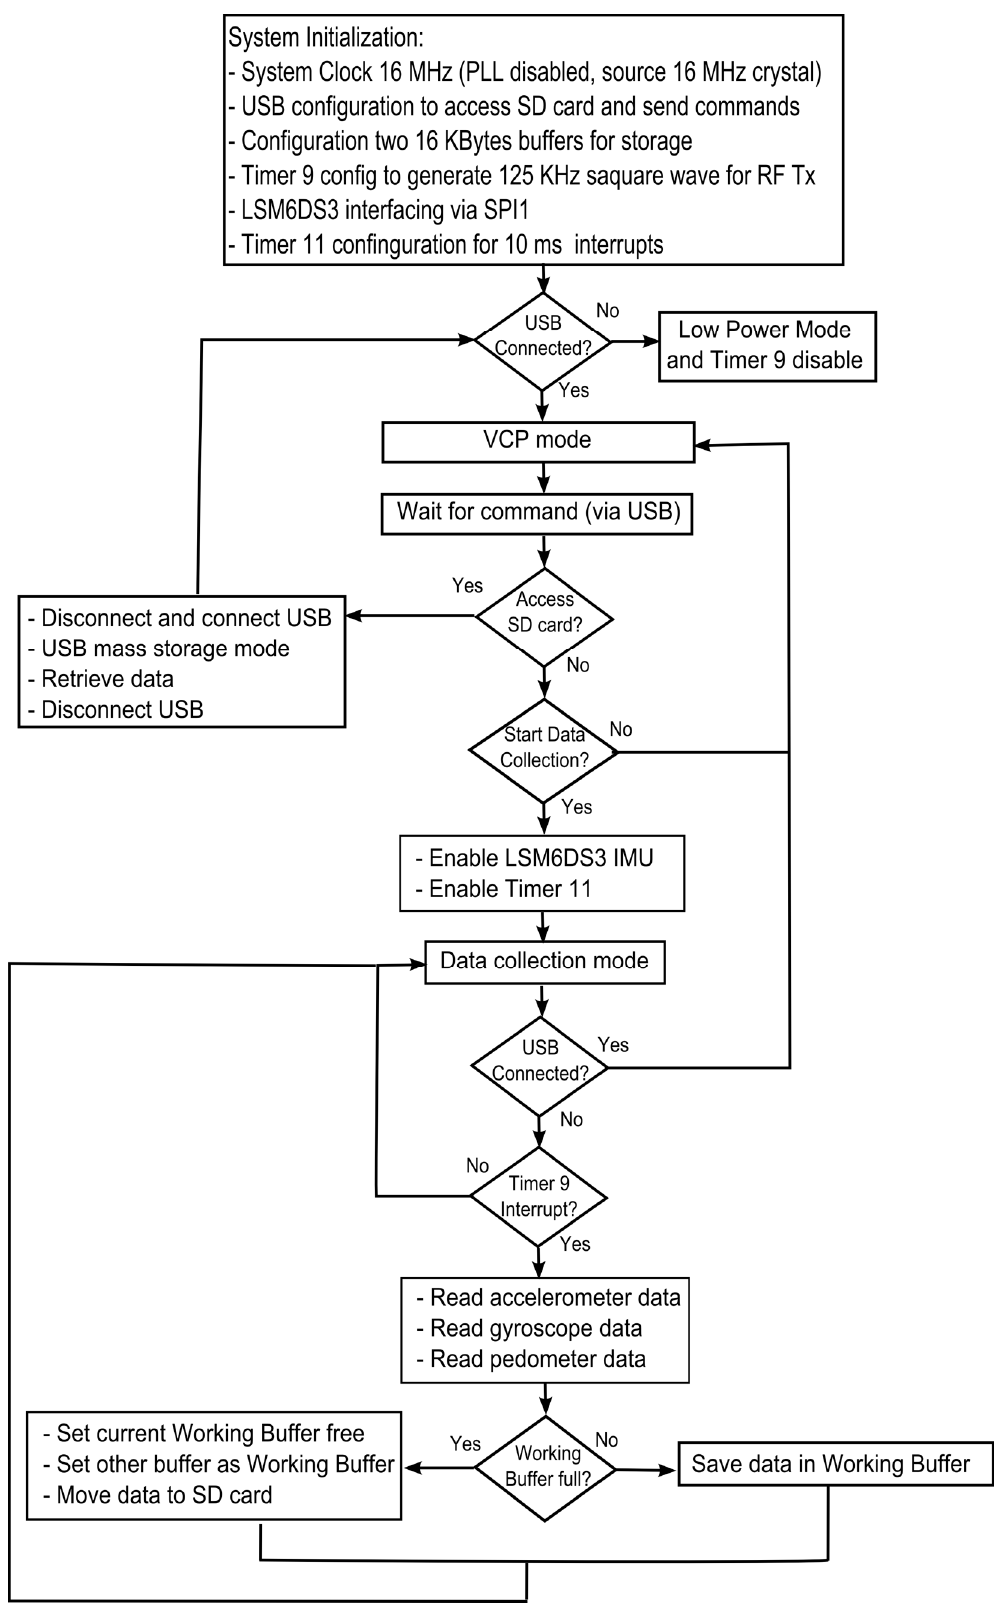
Figure 11. Hand module firmware.